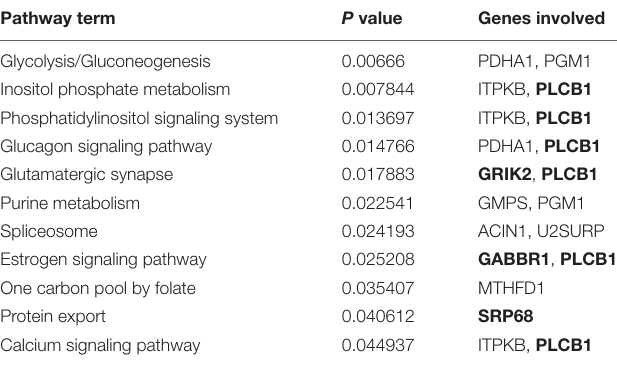
TABLE 3 | Genes involved in significantly enriched KEGG